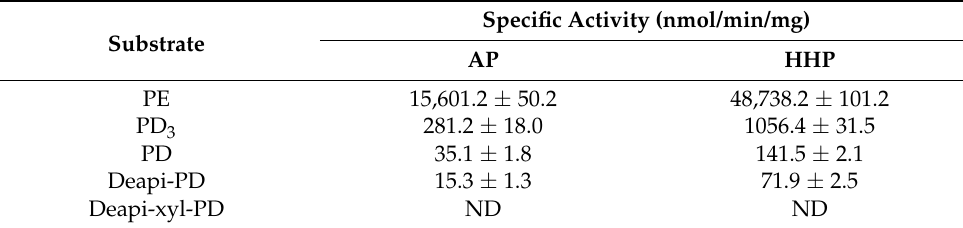
Table 1. Specific activities of cytolase PCL5 for different platycoside substrates under AP and HHP.